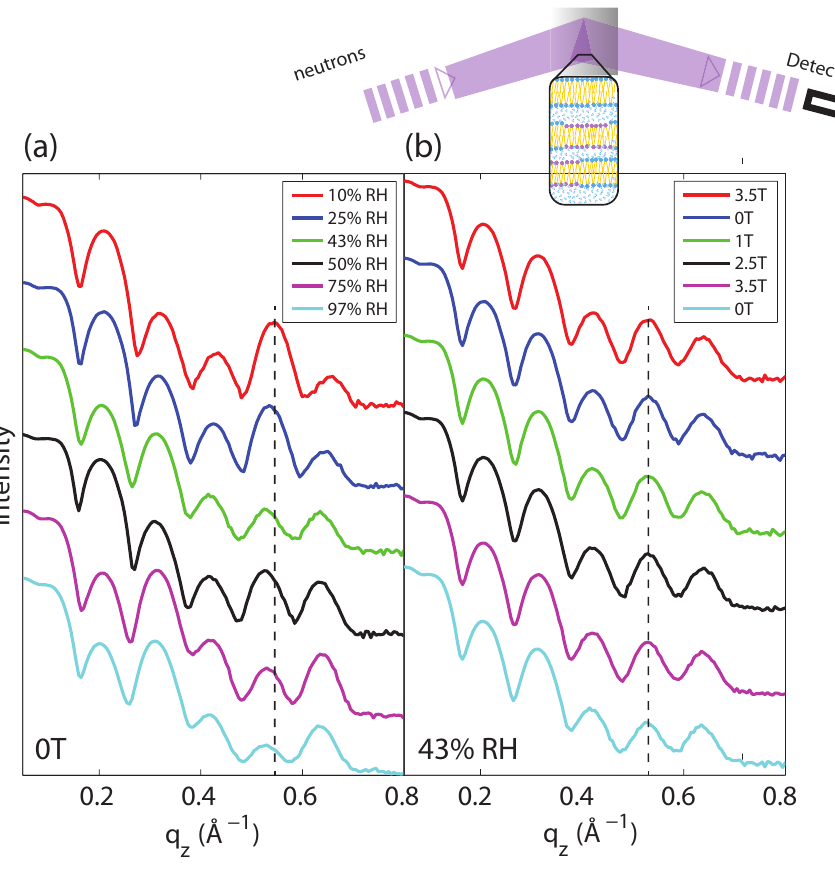
Figure 2. ( a ) Out-of-plane scans for DMPC/DPPC (1:1) membranes measured at different levels of hydration. The well-developed and equally spaced Bragg reflections indicate that the membranes form well-organized lamellar structures. ( b ) Out-of-plane scans at 43% relative humidity at magnetic field strength of 0 T → 3.5 T → 2.5 T → 1 T → 0 T → 3.5 T. All curves agree within the resolution of our experiment, indicating that the magnetic field does not change the lamellar structure of the